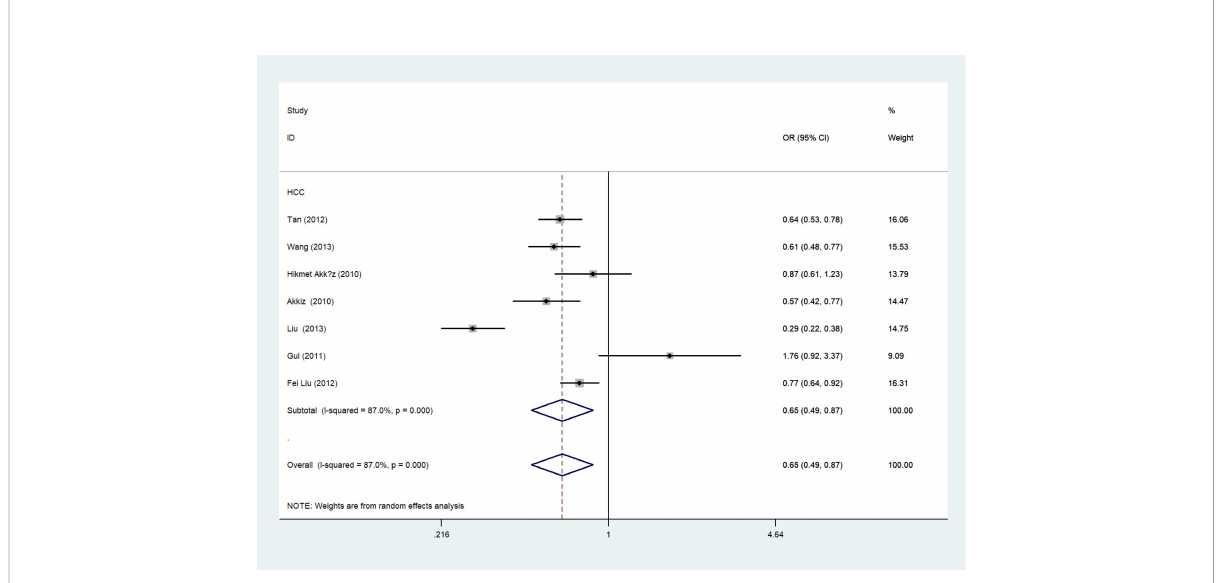
FIGURE 3 Forest plot about the relationship between the risk of HCC and the NQO1 gene rs1800566 polymorphism (C-allele vs. T-allele model). There were signi fi cantly decreased association between NQO1 polymorphism and HCC susceptibility. The squares and horizontal lines correspond to the study- speci fi c OR and 95% CI. The area of the squares re fl ects the weight (inverse of the variance). The diamond represents the summary OR and 95%